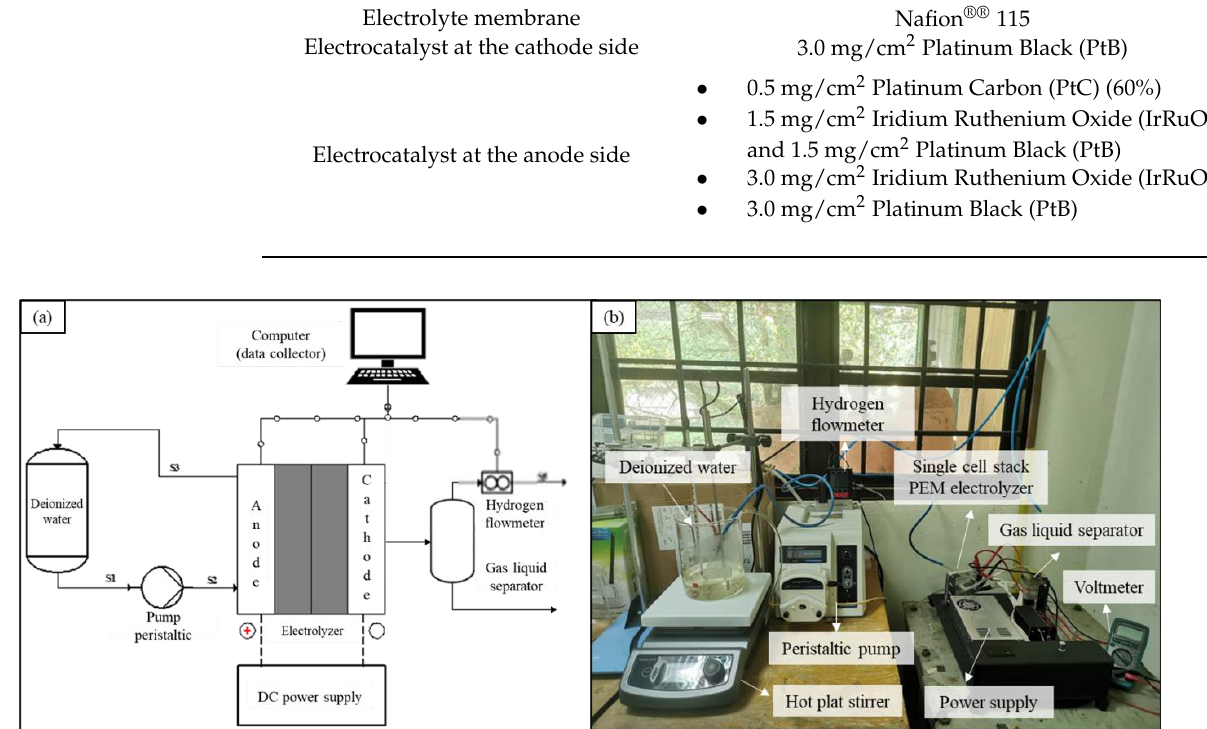
Figure 2. ( a ) Schematic diagram and ( b ) actual photo of the experimental